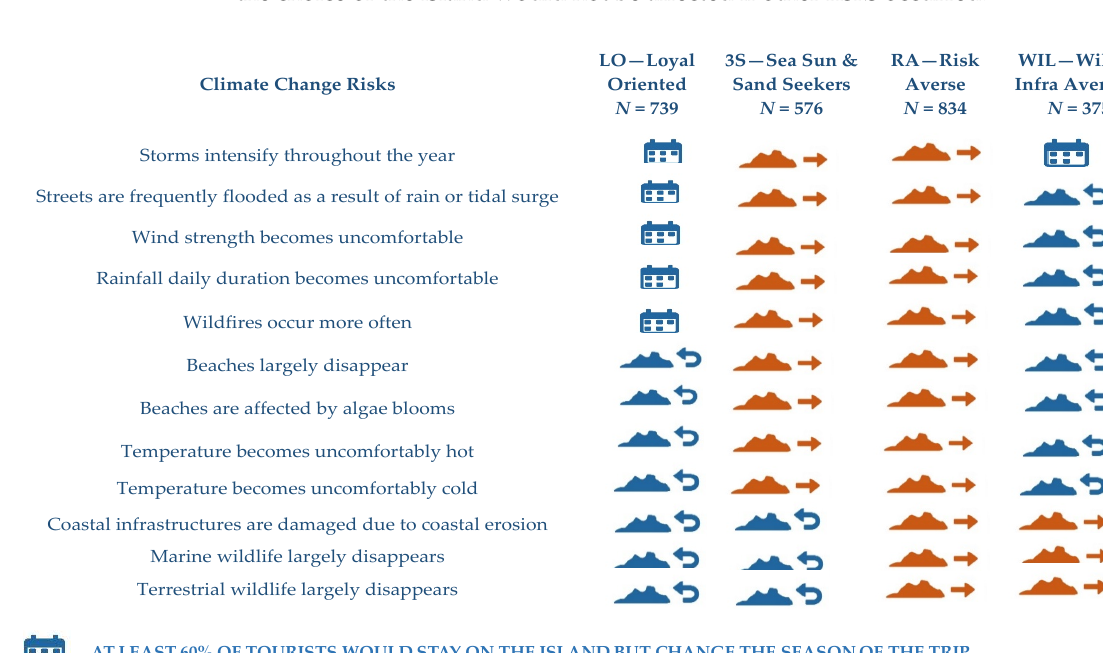
Figure 2. Final cluster structure.